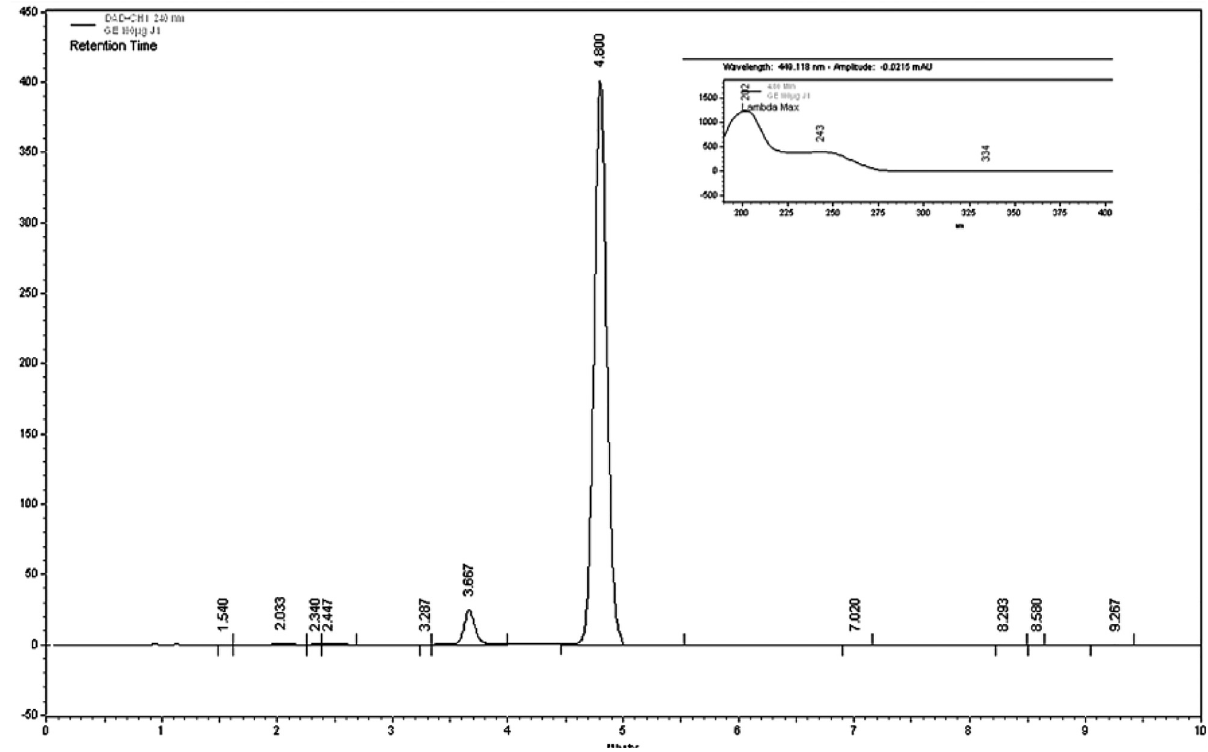
Figure 1: Chromatogram of 25 mg/mL azacitidine suspension (diluted at 100 µg/mL for HPLC analysis) and UV spectrum without stressed conditions.